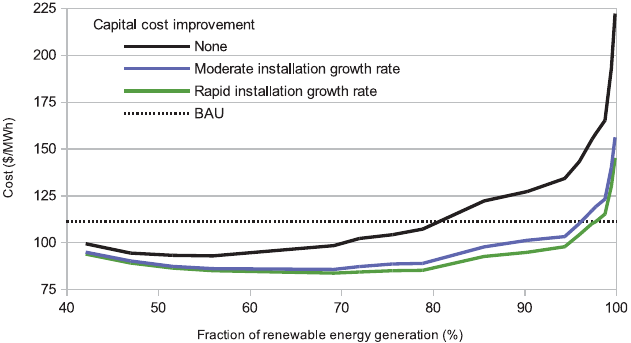
Fig. 4. Cost of partial renewable energy generation scenarios compared to business as usual (BAU) case (dashed line) with a $24 per tonne carbon price. Renewable technologies used are wind, solar photovoltaic and distributed battery storage. Black line is no cost improvement over time, blue line is global cost improvement rates and moderate installation growth rates. Green line is global cost improvement rates and rapid installation growth rates. Cost is in Australian dollars.